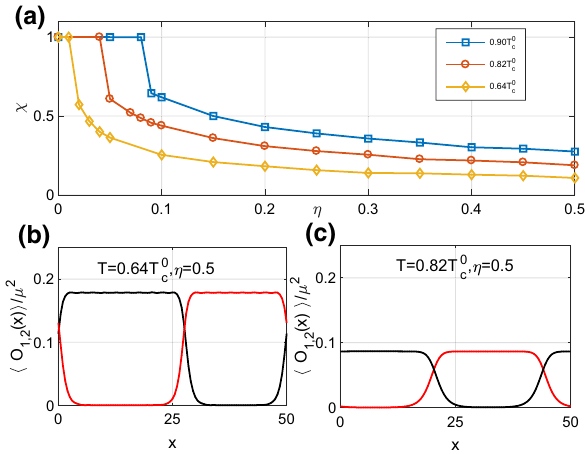
Fig. 1 a , b The overlap factor χ as a function of η . c , d The configura- tion of (cid:3) O 1 ( x ) (cid:4) (black line) and (cid:3) O 2 ( x ) (cid:4) (red line) in a phase separated